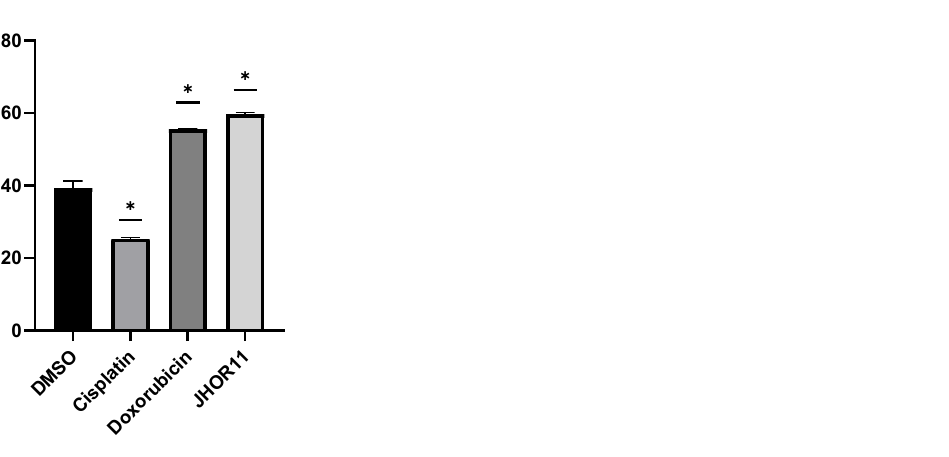
Figure 9. Analysis of the cell cycle for 5 h, 9 h, 24 h or 32 h of A2780 cells after exposure to IC 50 of complex JHOR11, 0.1% ( v / v ) DMSO as vehicle control or 0.1 μ M doxorubicin (Doxo) as positive control. Bars represent the average ± SD of at least three independent experiments. * p value < 0.05,